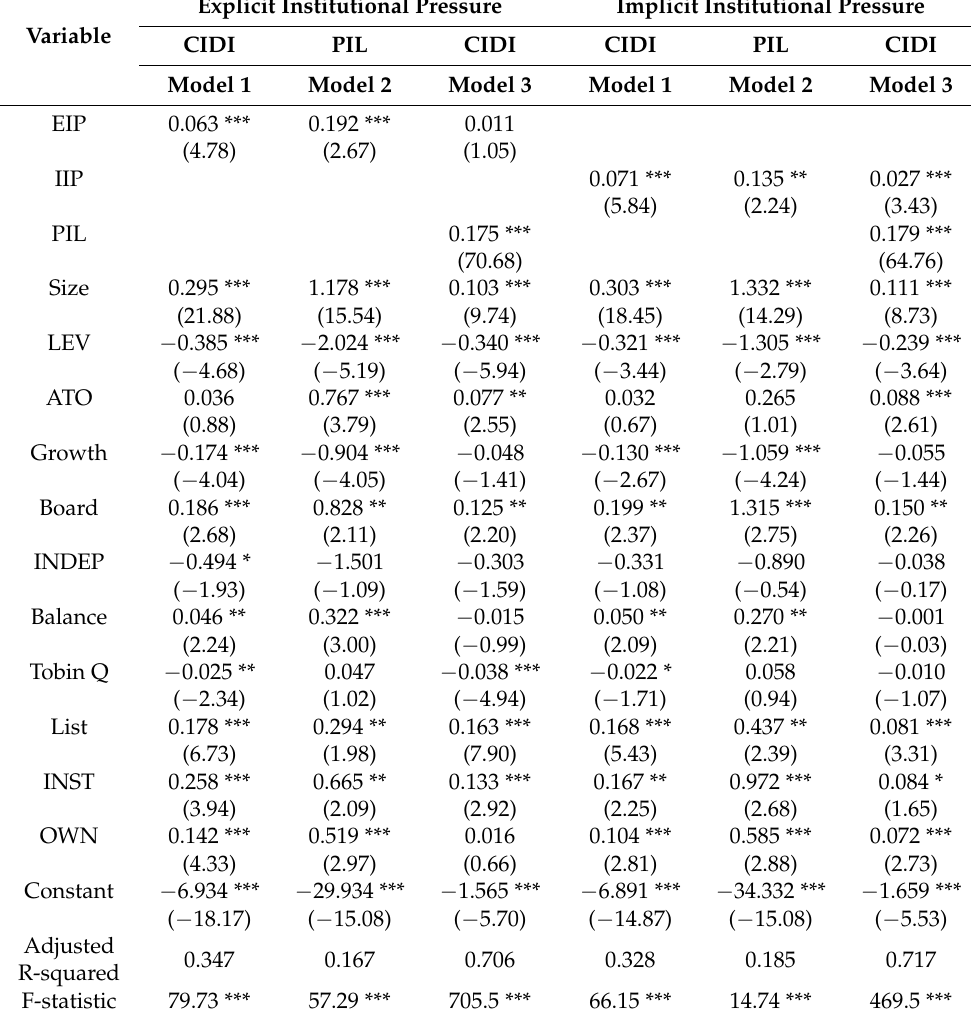
Table 7. Results of robustness